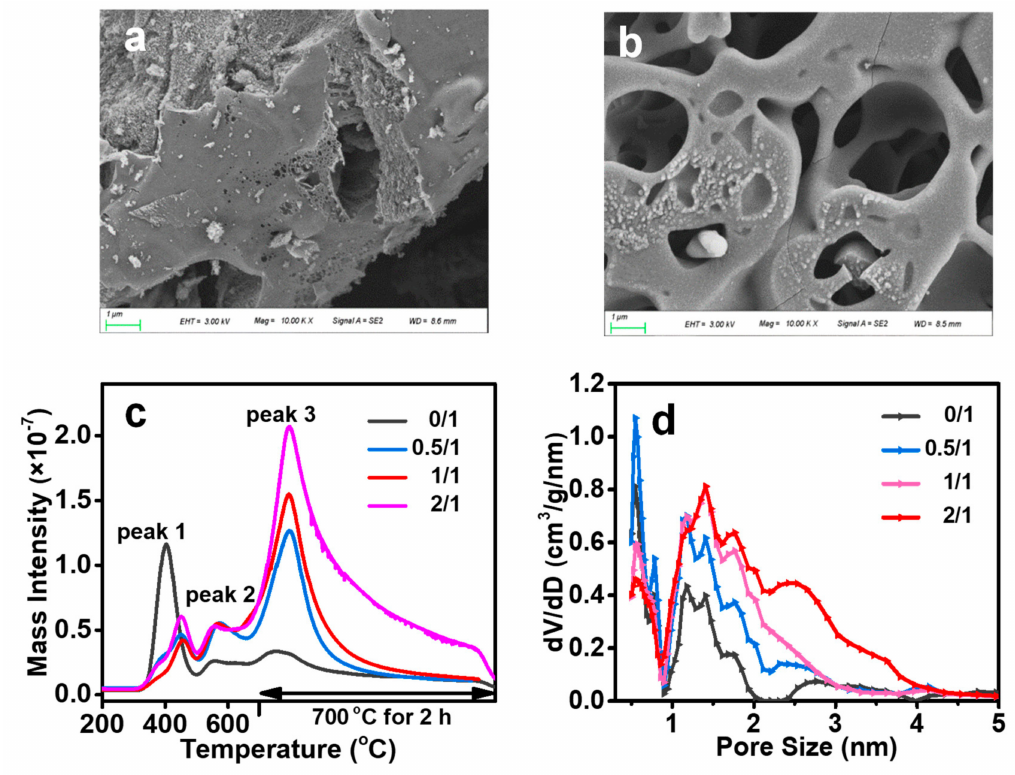
Figure 2. ( a ) Typical SEM images of NSC prepared by thermal activation of KSCN, ( b ) SEM images of NSC prepared by thermal activation of K 2 CO 3 and KSCN, ( c ) the CO release graphs and ( d ) dis- tribution of pore sizes of NSC, which were activated with various loading contents of K 2 CO 3 . The activation conditions were set to be 700 ◦ C, KSCN: biomass mass ratio = 1:1, K 2 CO 3 : KSCN: biomass mass ratio =